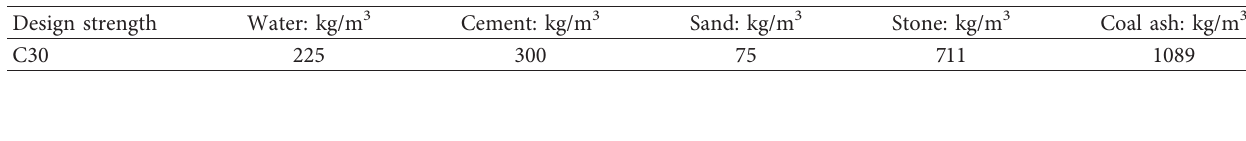
Table 3: Mechanical properties of concrete.